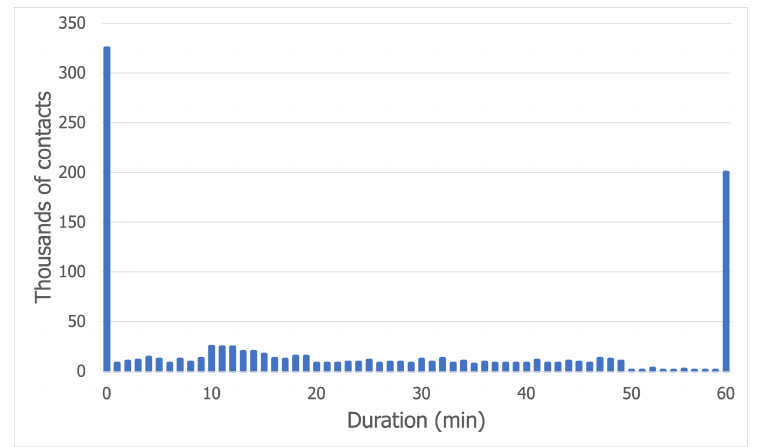
Figure 5. Contact duration distribution for the Bluetooth trace.